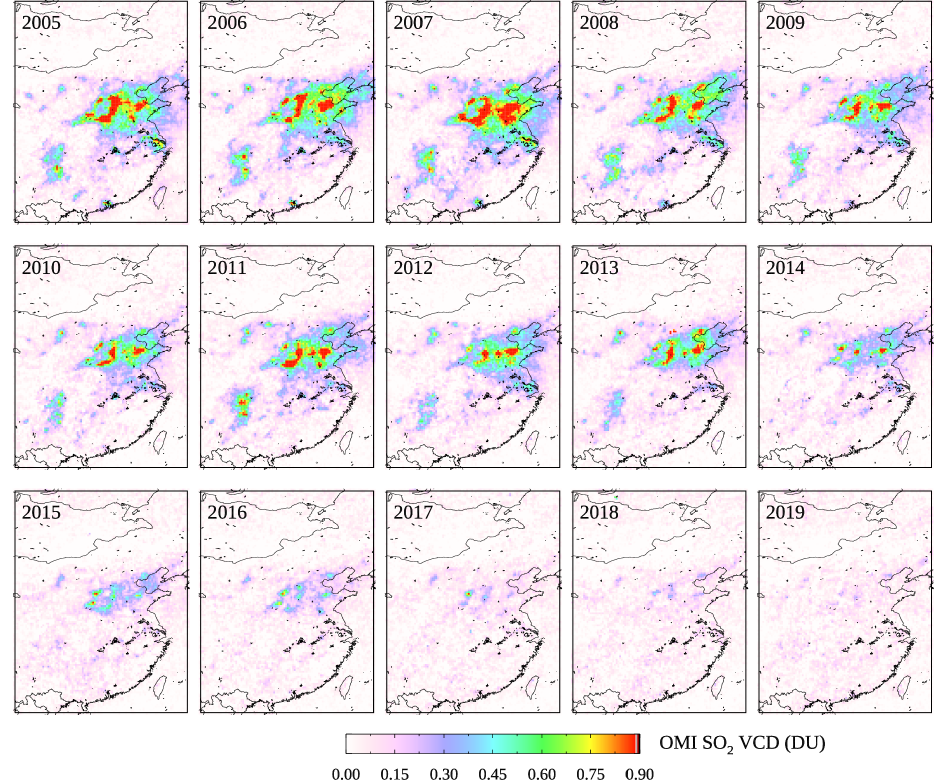
Figure 8. Mean warm season (April to October) OMI SO 2 VCDs over eastern China from the new anthropogenic SO 2 dataset in OMSO2 V2 for different years during 2005–2019. Data have been gridded to 0.25 ◦ × 0.25 ◦ resolution using pixels from OMI rows 6–24 (1-based) with cloud radiance fraction < 0.3, SZA < 65 ◦ , and AMF at 313nm > 0.3. Mean SO 2 VCDs are calculated from the daily gridded data for each year, after excluding days potentially affected by large volcanic